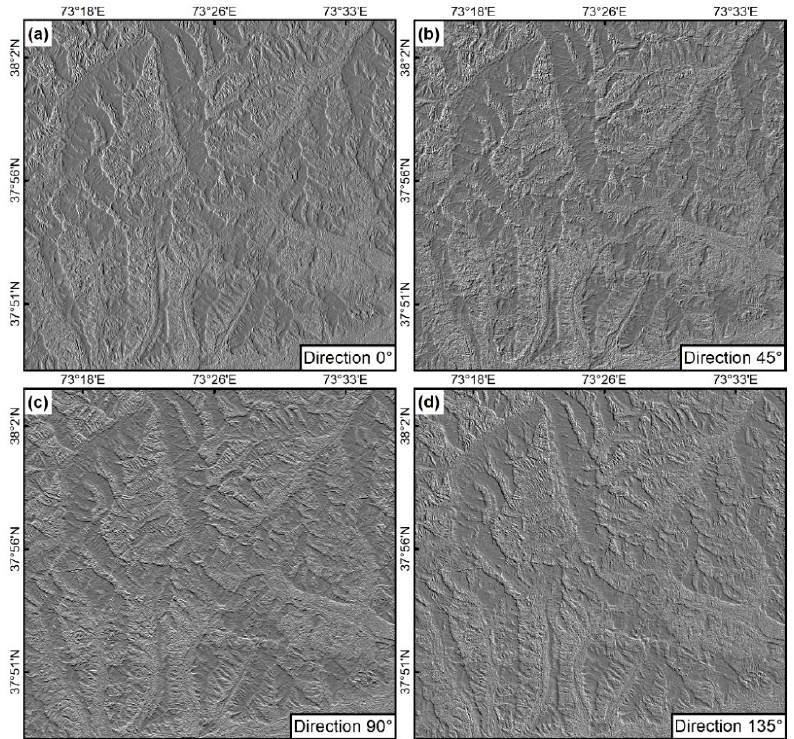
Figure 5. S1A VH polarization image filtered in the four main directions: ( a ) N–S direction (0), ( b ) NE–SW direction (45), ( c ) E–W direction (90), and ( d ) NW–SE direction (135).